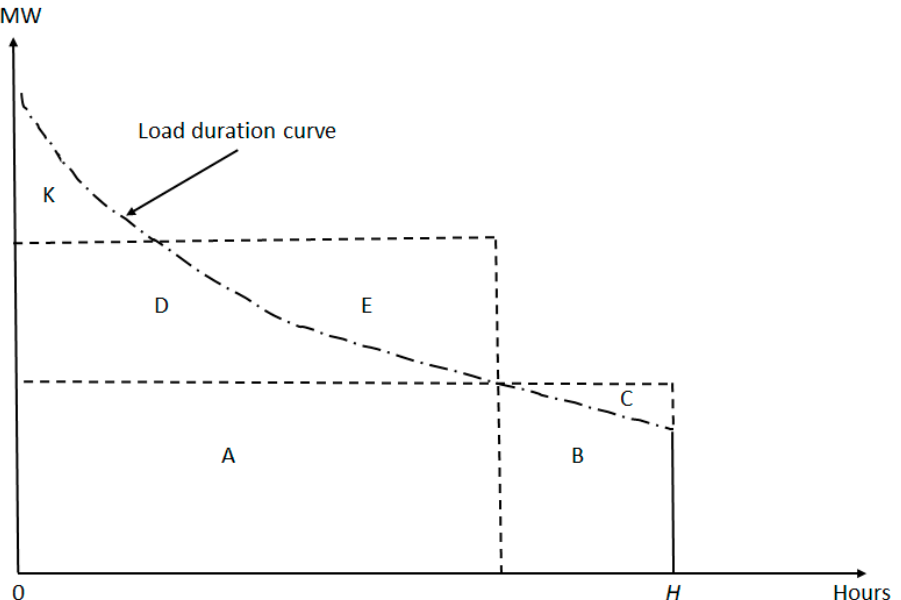
Figure 2. A hypothetical REP’s load duration curve, procurement of electricity forward contracts, and residually unhedged peak loads.